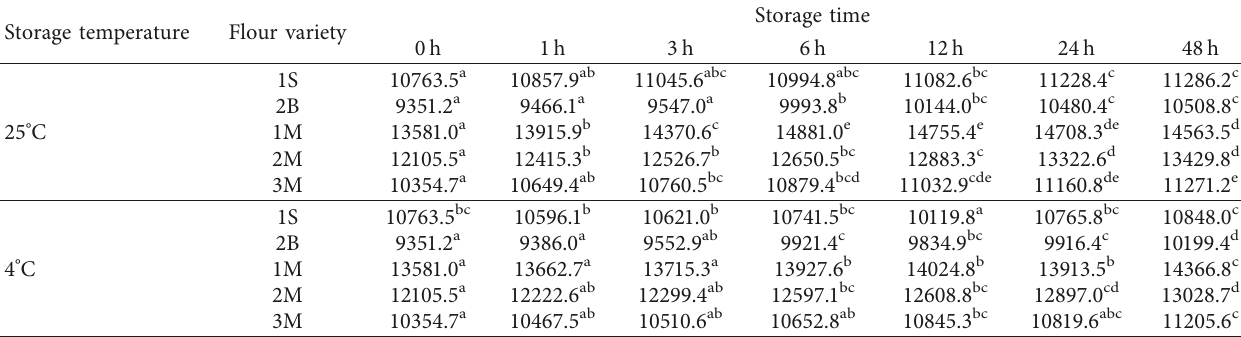
Table 2: Hardness of fresh wet noodles made from different flours during